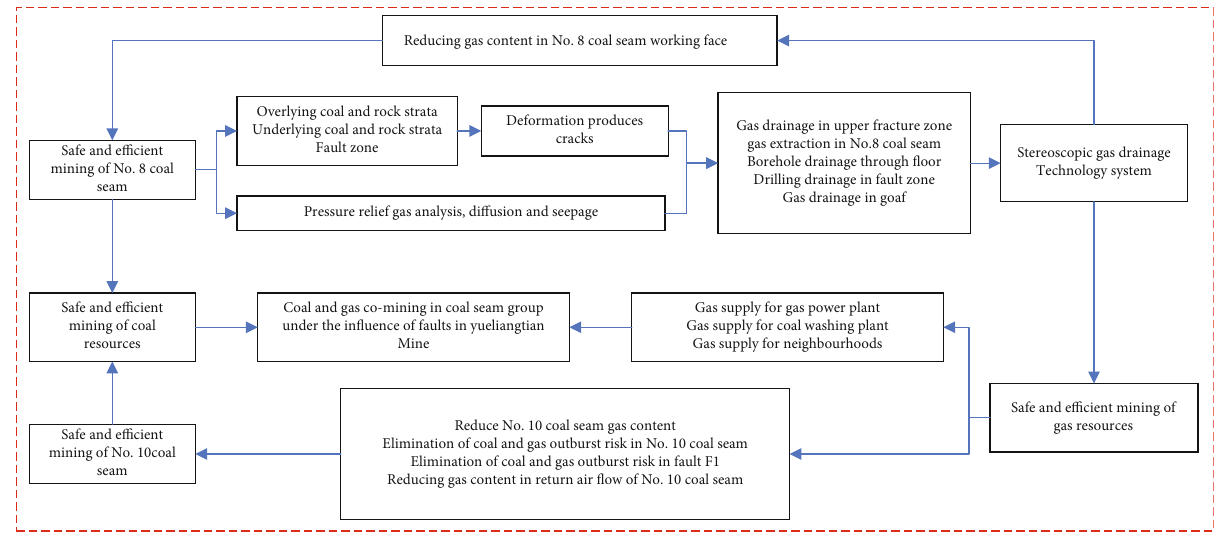
Figure 14: Co-mining technology system of coal and gas in coal seam group mining under the in fl uence of fault in Yueliangtian